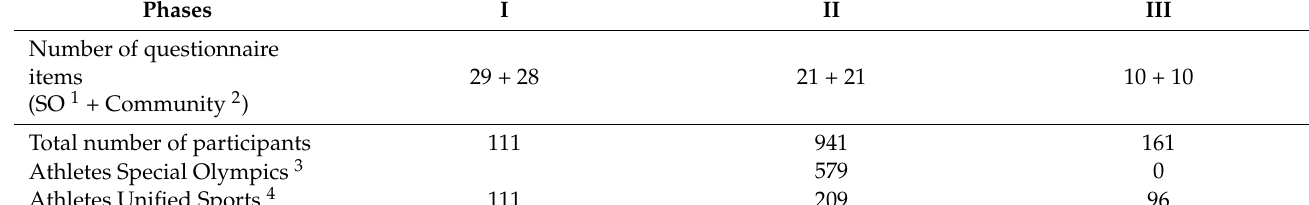
Table 1. Descriptive information of the three phases of questionnaire development.